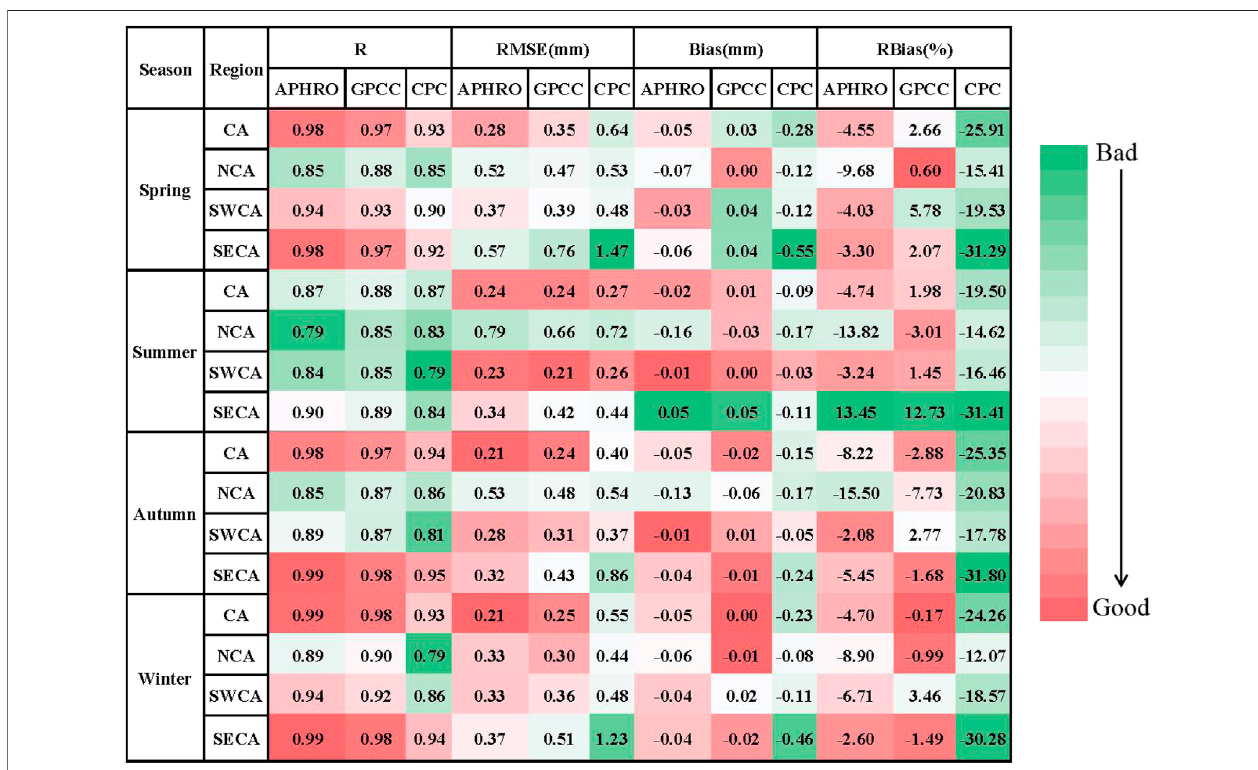
FIGURE 8 | statistic metrics of daily precipitation between OBS and three gridded products over the CA and subregion at seasonal scale.